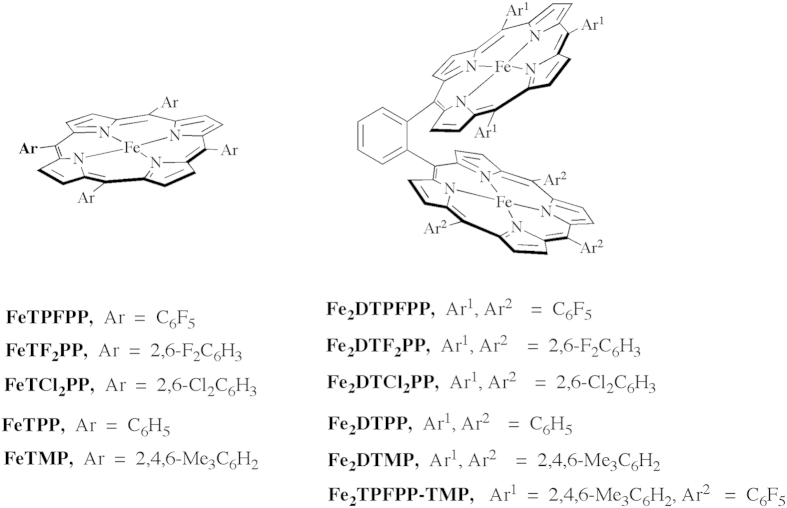
Chemical structures of the six Fe porphyrin dimers and their corresponding monomers.